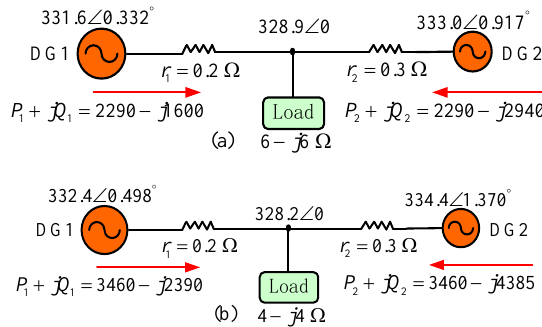
Figure 10. Simulation parameters and results in Case D: ( a ) during 0–0.7 s and 1.4–2 s; and ( b ) during 0.7–1.4 s.